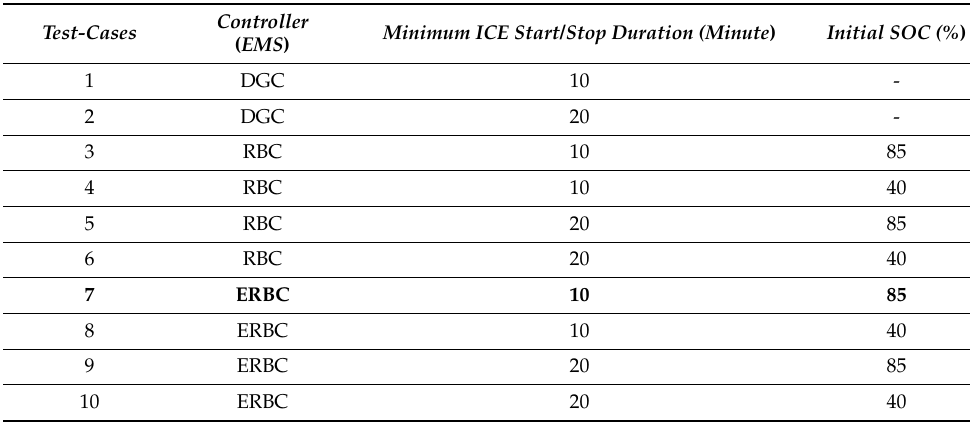
Figure 12. A representative load profile of the HEMV. Table 5. Test-cases